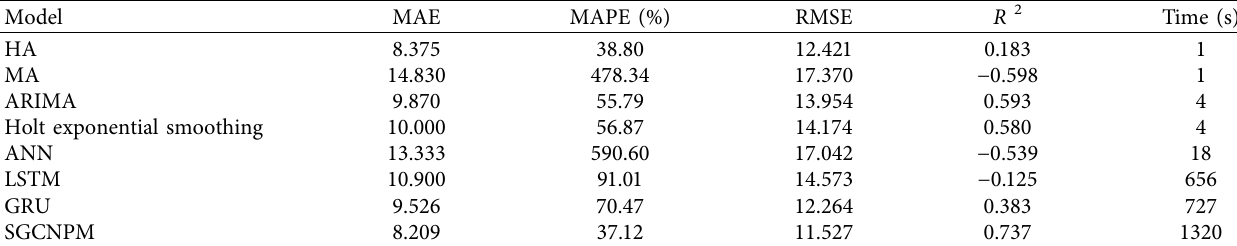
Figure 12: Heat maps of the errors. Table 3: Result comparison of diferent models for bike-sharing demand forecasting.